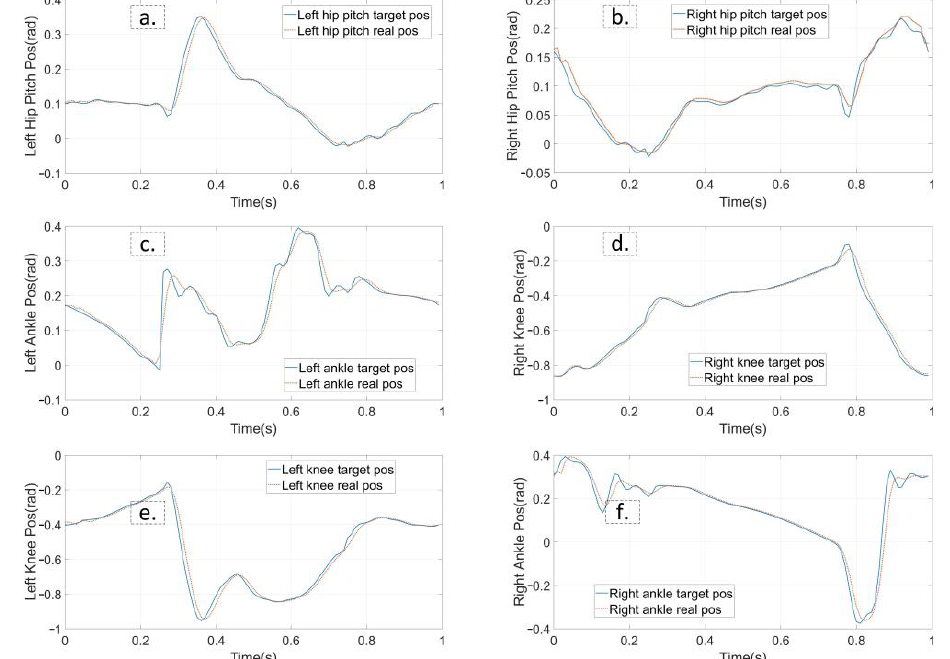
Figure 9. The planned joint position trajectories and the feedback trajectories from simulation of stairs. The tracking performance of each active joint of stepping stairs is shown from ( a – f ). The target position trajectories is represented in blue and real trajectories in red.